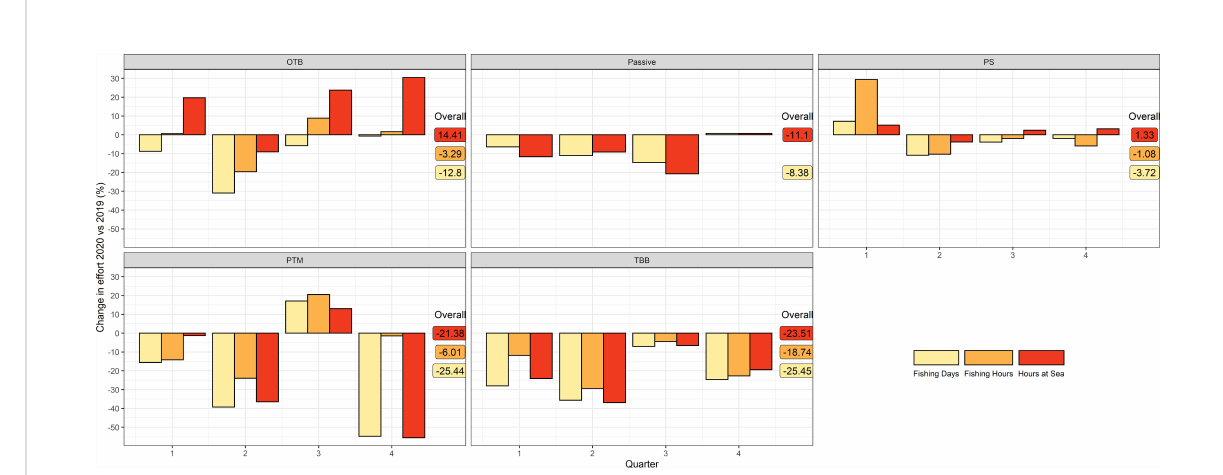
FIGURE 1 Seasonal change in fi shing effort in the period 2019 – 2020 in the Adriatic Sea (GFCM-GSAs 17 and 18). Fishing days and hours at sea are derived from FDI data (STECF, 2021a) fi shing hours from AIS data taken from Coro et al., 2022c. Metièrs are otter bottom trawlers (OTB), purse seiners (PS), pelagic midwater trawlers (PTM), and beam bottom trawlers (TBB). TBB comprises dredgers (DRB) from Croatia that are using beam trawl. Passive gears include the following gears: FPO, FYK, GND, GNS, GTN, GTR, HMD, LHM, LHP, LLD, LLS, LTL; Other include the following gears: OTM, NK, SB, SV. Acronyms full list available at